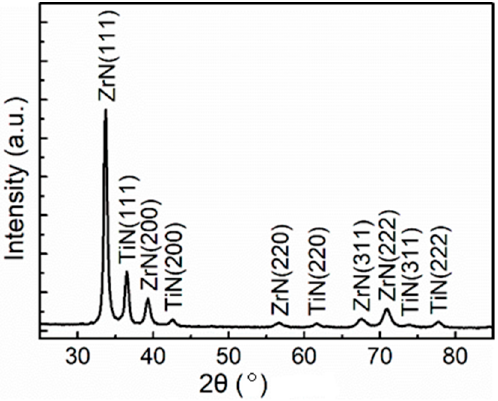
Figure 2. XRD diffraction pattern of the TiN/ZrN nanoscale multilayer coating.